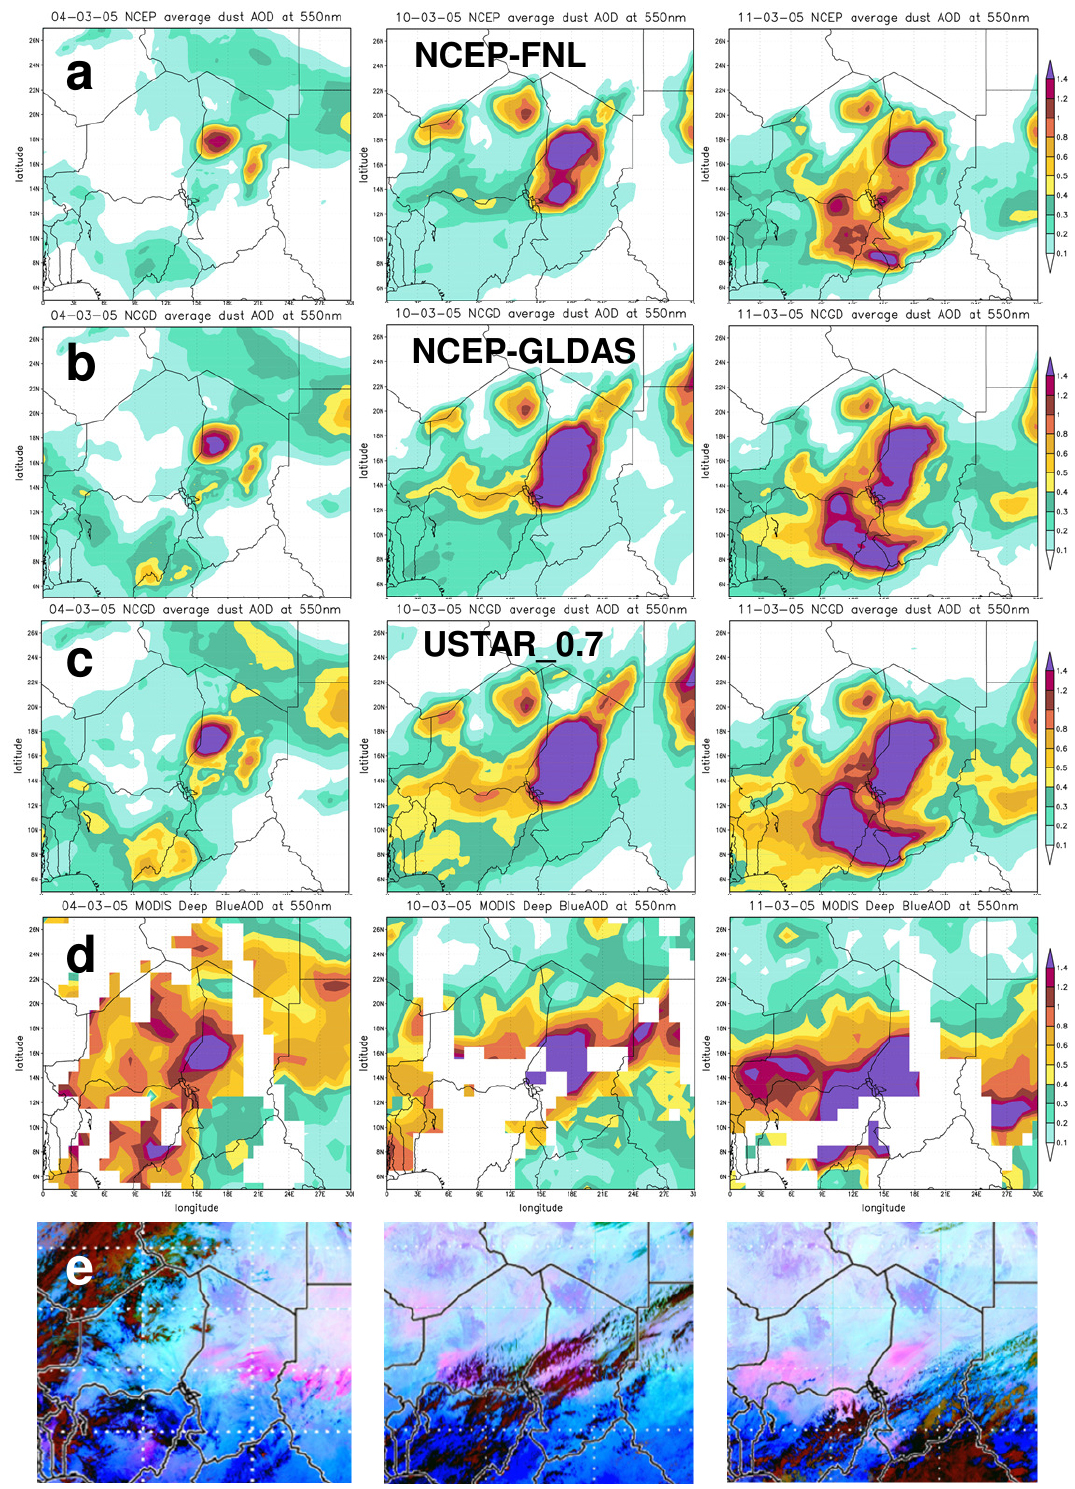
Fig. 16. Four hour average of model AOD for the 3 experiments: NCEP-FNL (a) , NCEP-GLDAS (b) , NCEP-GLDAS with reduced threshold friction velocity (c) . MODIS DB AOD (d) and MSG dust image at 12:00UTC (e) on 4, 10, 11 March 2005 are displayed for the limited regional domain (5 ◦ N to 27 ◦ N and 0 ◦ W to 30 ◦